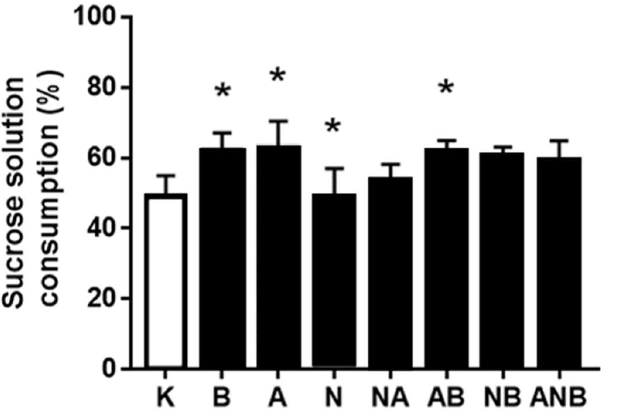
Figure 9. Sucrose solution consumption day 2 (%). Ketamine-induced sucrose consumption is shown in the sucrose preference test (SPT), mean values, and 95 percent confidence intervals. Sucrose